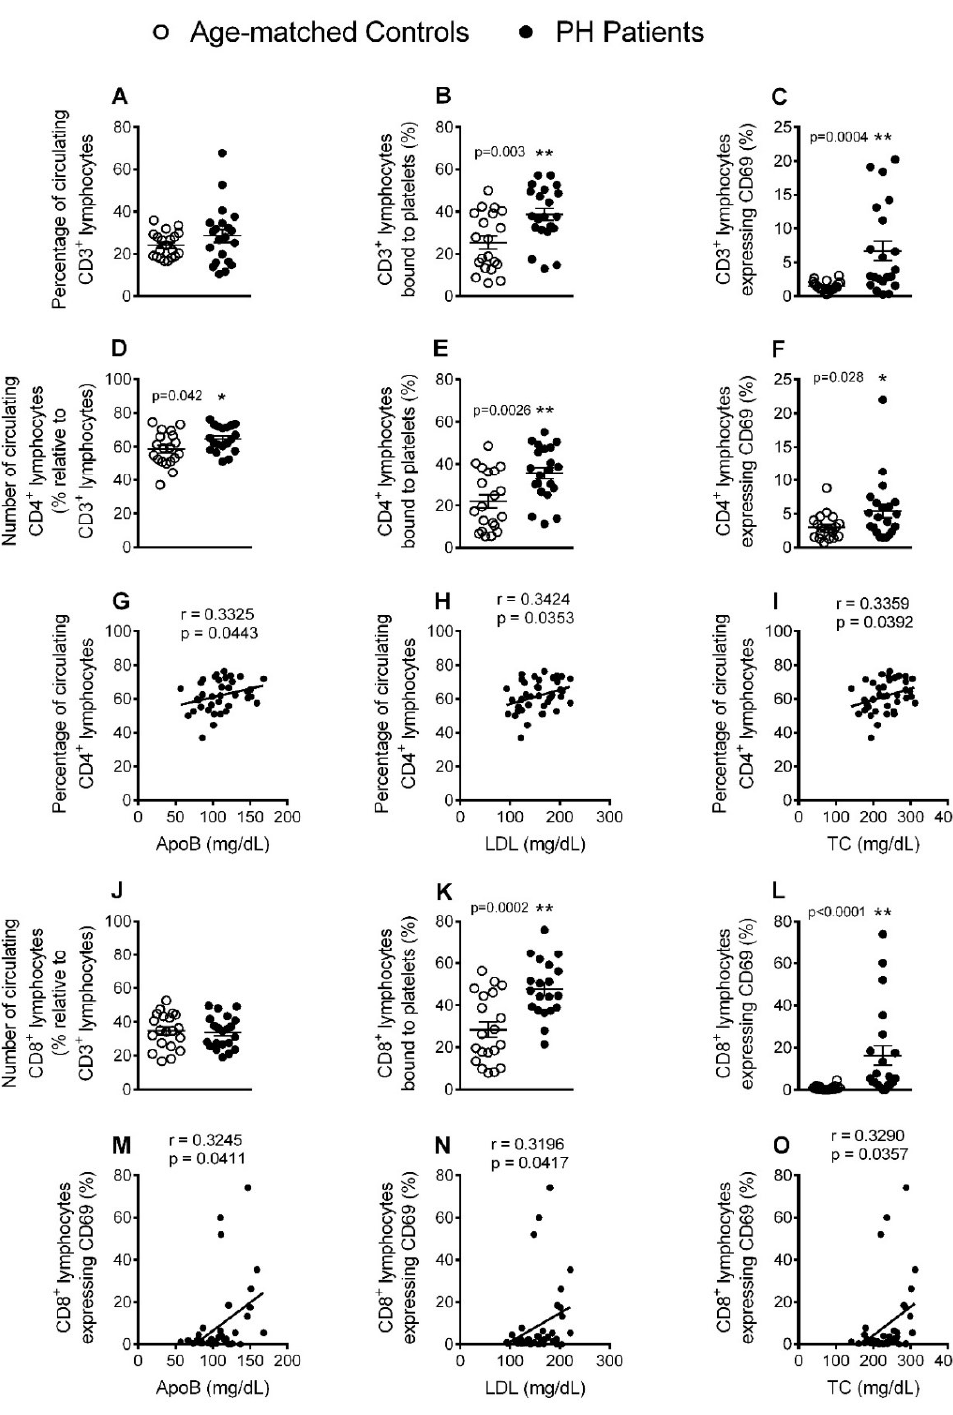
Figure 4. The percentage of circulating CD4 + lymphocytes, platelet-lymphocyte (CD4 + and CD8 + ) aggregates, and lymphocyte (CD4 + and CD8 + ) activation, are significantly elevated in patients with PH. Heparinized whole blood was co-stained with specific markers for platelets and CD3 + , CD4 + and CD8 + lymphocytes ( A , B , D , E , J and K ) as well as for CD69 ( C , F and L ). Results are expressed as the percentage of positive cells ( n = 21 control subjects and n = 22 PH patients). Values are expressed as mean ± SEM. * p < 0.05 or ** p < 0.01 relative to values in the control group. Correlations between circulating CD4 + cells and activated CD8 + lymphocytes and ApoB ( G and M ), LDL ( H and N ) and TC ( I and O ) plasma levels.